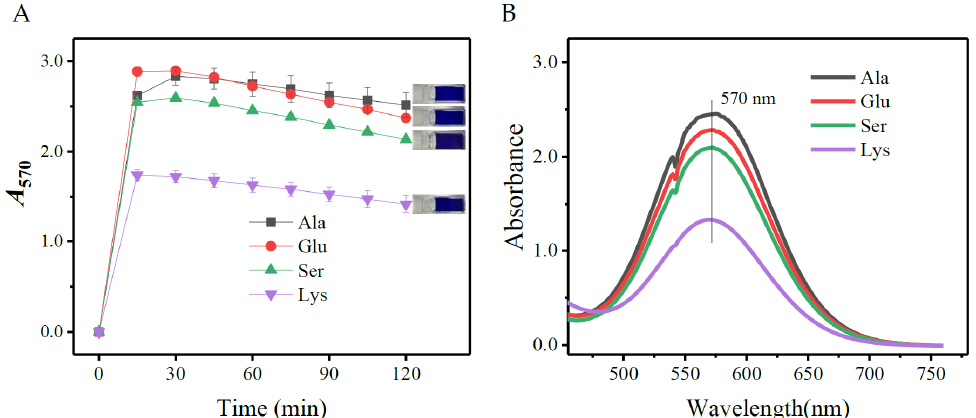
Figure 10. Chromogenic reactions of several amino acids performed by SINICS. ( A ) chromogenic processes; and ( B ) wavelength scans of chromogenic products. The rightmost part of diagram A shows the reacted mixtures of the selected amino acids (from top to bottom: L-alanine, L-glutamic acid, L-serine, and L-lysine). SINICS: sensitivity intensified ninhydrin-based chromogenic system; and A 570 : absorbance at 570 nm.